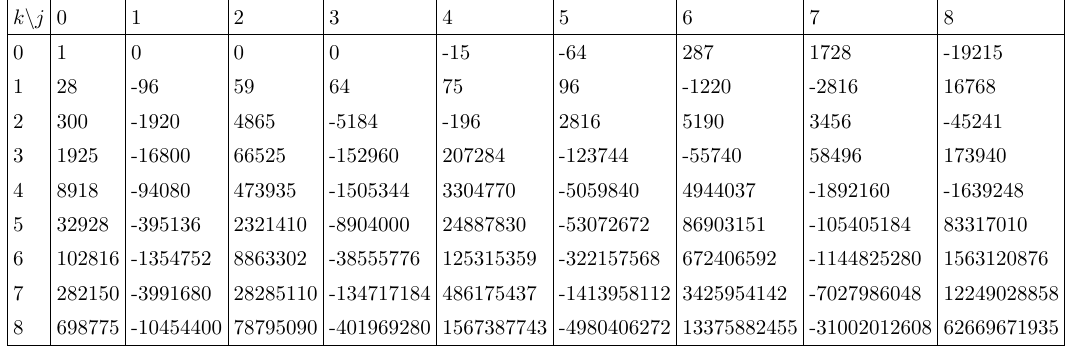
Table 57. Table of b jk coe(cid:14)cients for h SO(8)